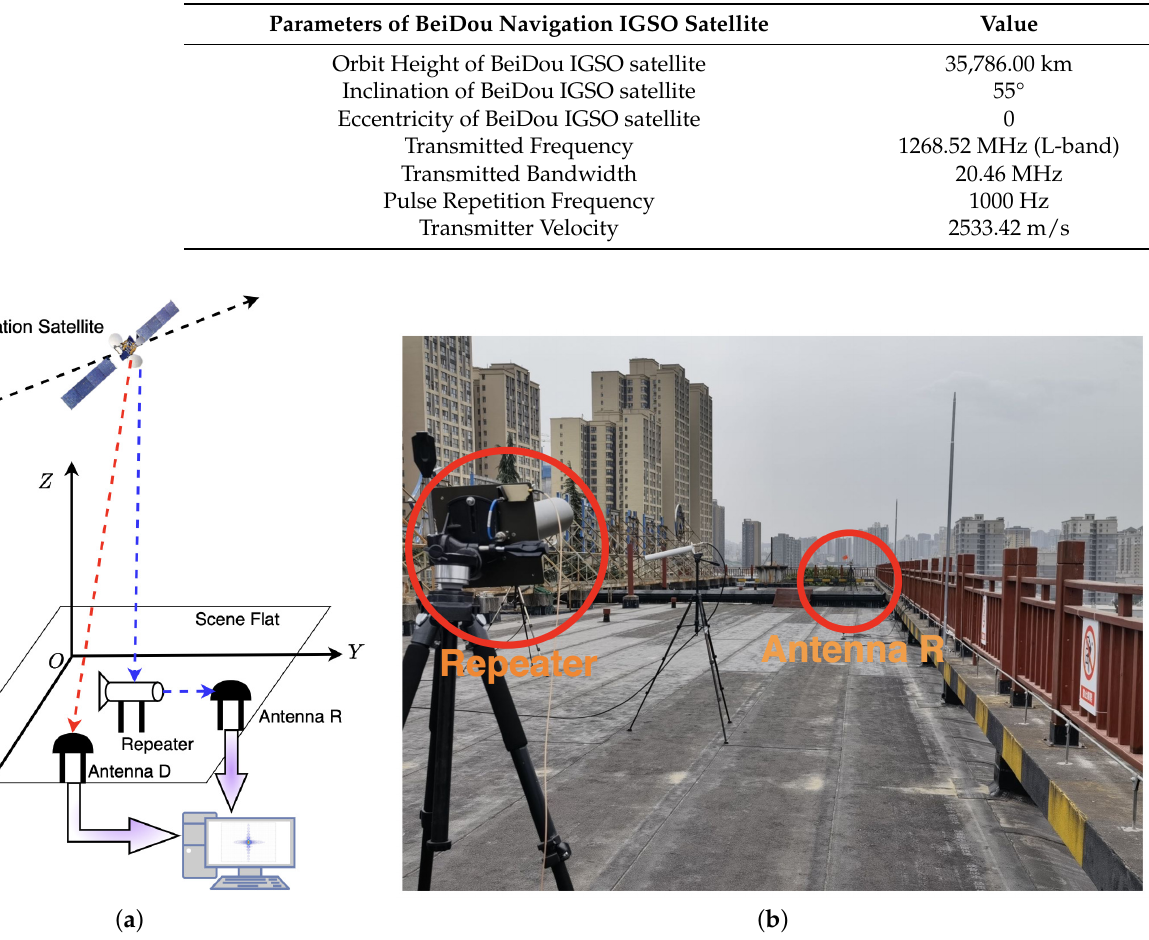
Figure 15. The geometry and ground receiving equipment of our equivalence verification experiment. ( a ) The geometry of satellite-ground SAR system. ( b ) Setup of the experiment we conducted on the